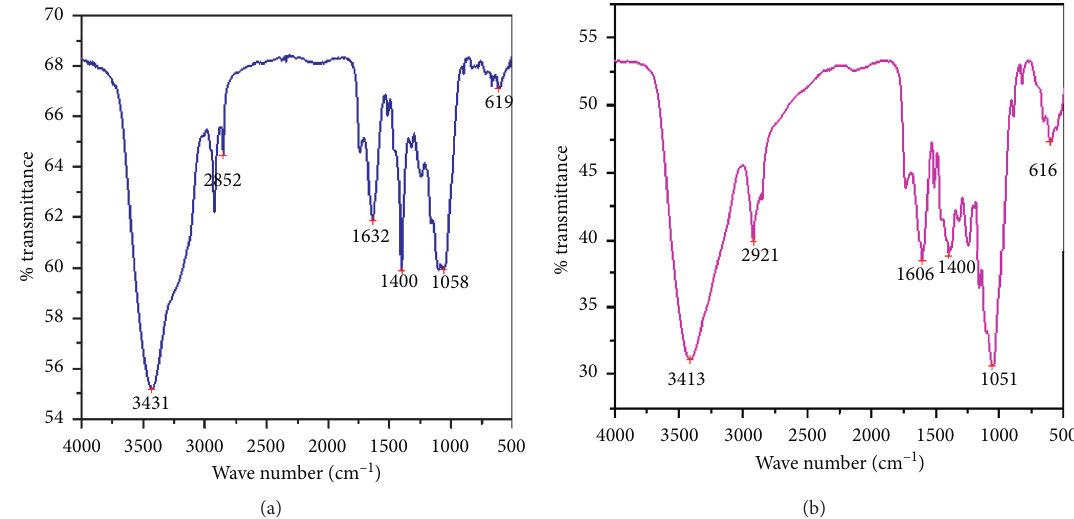
Figure 8: FTIR spectrum of the ethanol yield for pretreated acid of stalk residues of sweet sorghum. (a) Chiquere variety; (b) Gebabe variety.